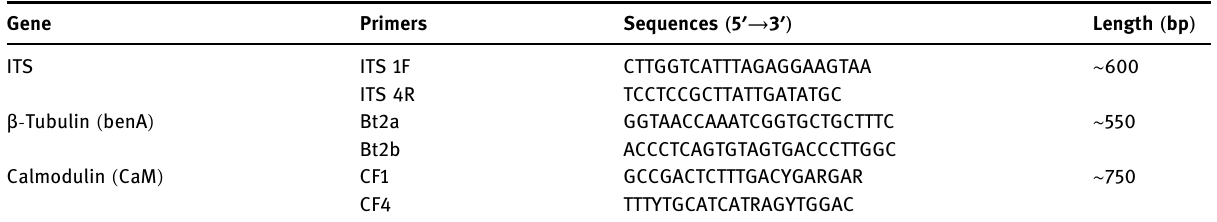
Table 1: Primers used for Penicillium species identi fi cation Gene